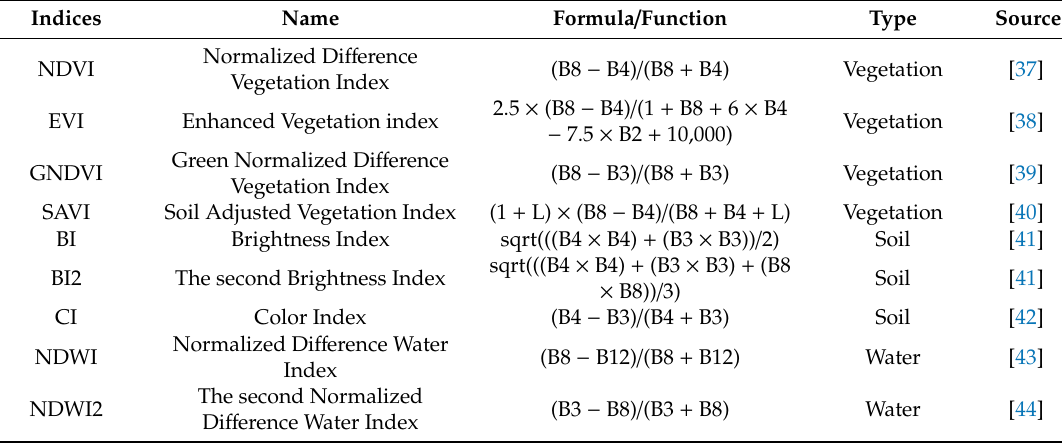
Table 1. Vegetation, soil and water indices derived from Sentinel-2 images. The resulting information layers were used for segmentation and classification images during the mung bean growing season from February 6 through April 17 of 2019 in Barisal division of coastal